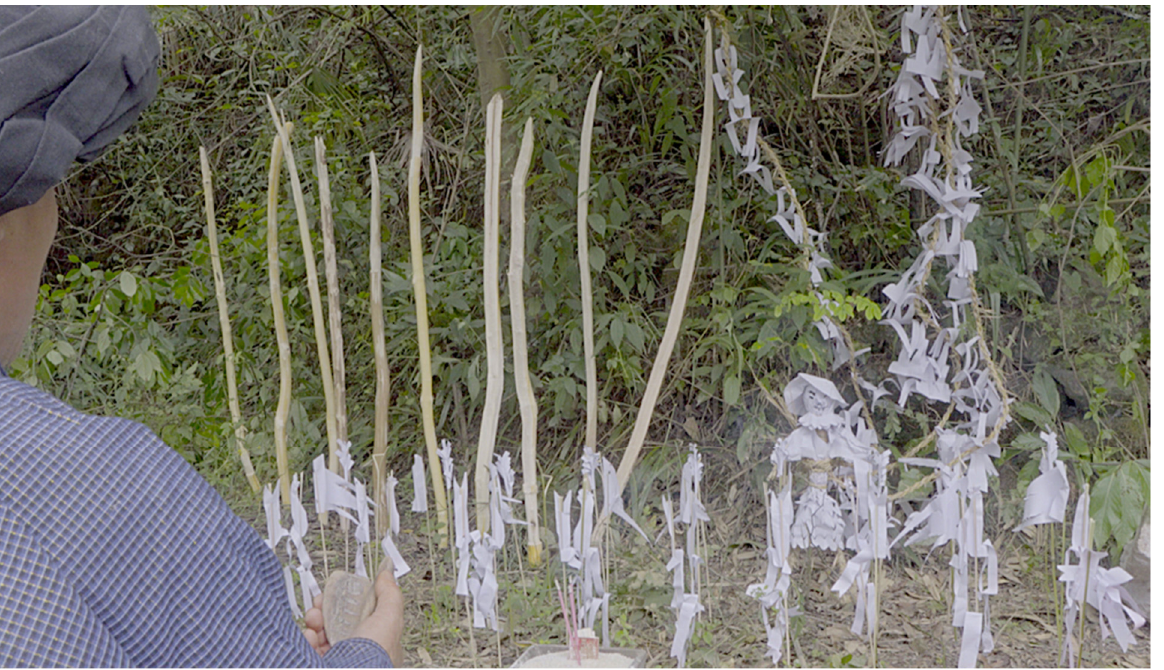
Figure 18. Badai Yang addressing the army of the general, which are represented by the paper flags. At the center of the altar is the Doll Ghost. To the left are ten spears representing those that will be used to sacrifice the water buffalo.